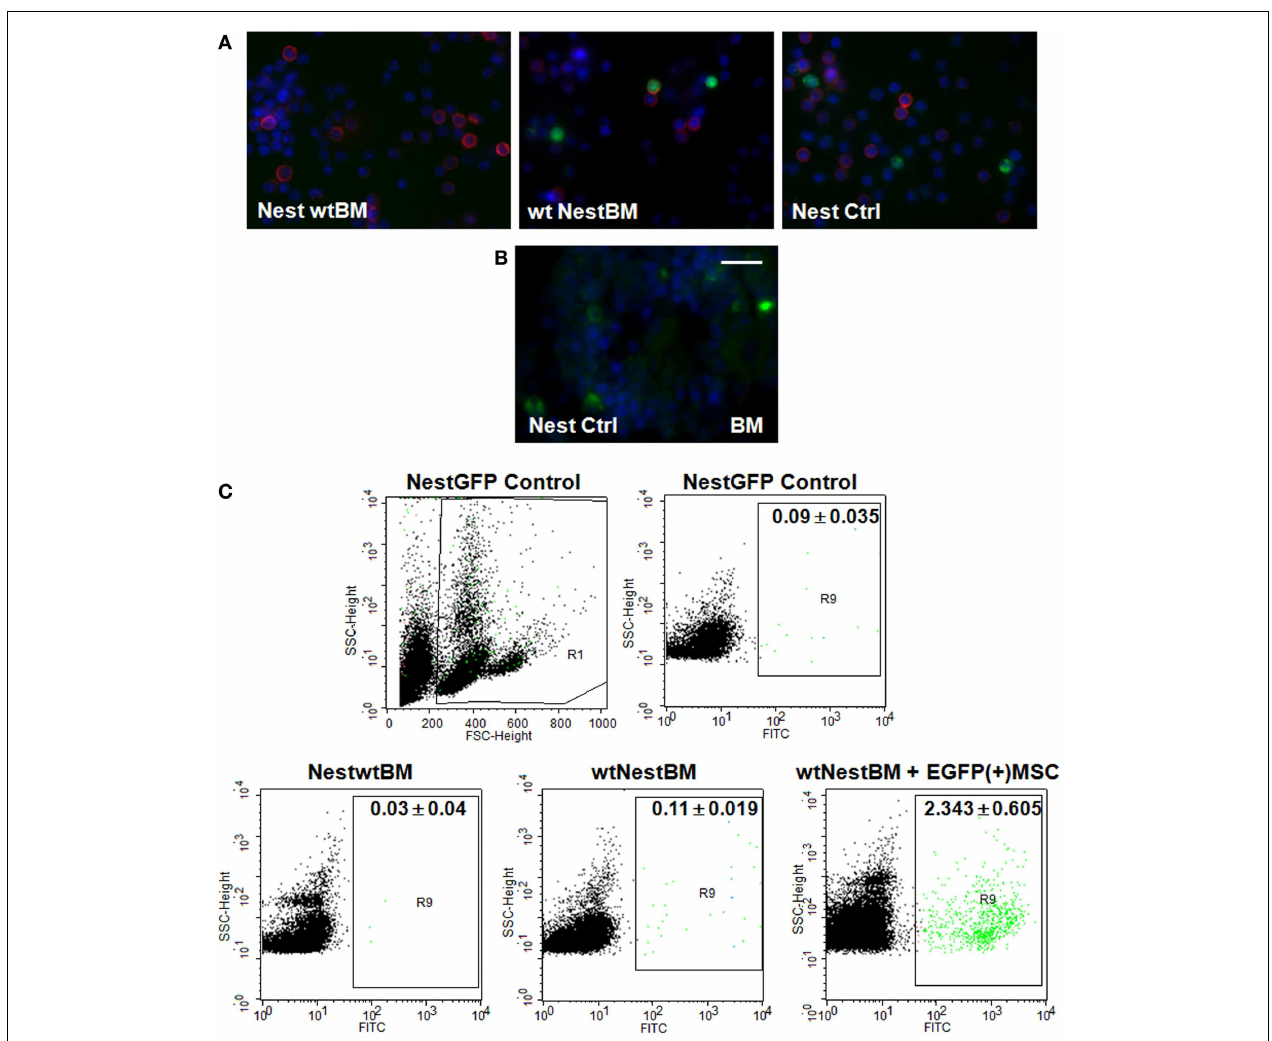
MSC]. After hematopoietic reconstitution (6–8weeks after transplantation) blood samples were taken, erythrocytes were removed, and analyzed for GFP-expression by immunofluorescence. Lymphocytes are stained in red. (B) Paraffin-sections of Nest-GFP BM specimen were stained for GFP-expression. (C) The blood analysis showed a complete engraftment of donor BM by the donor BM-derived Nest-GFP transplanted progenitor cells and vice-versa as indicated by GFP-expression. Control, normal Nest-GFP transgenic